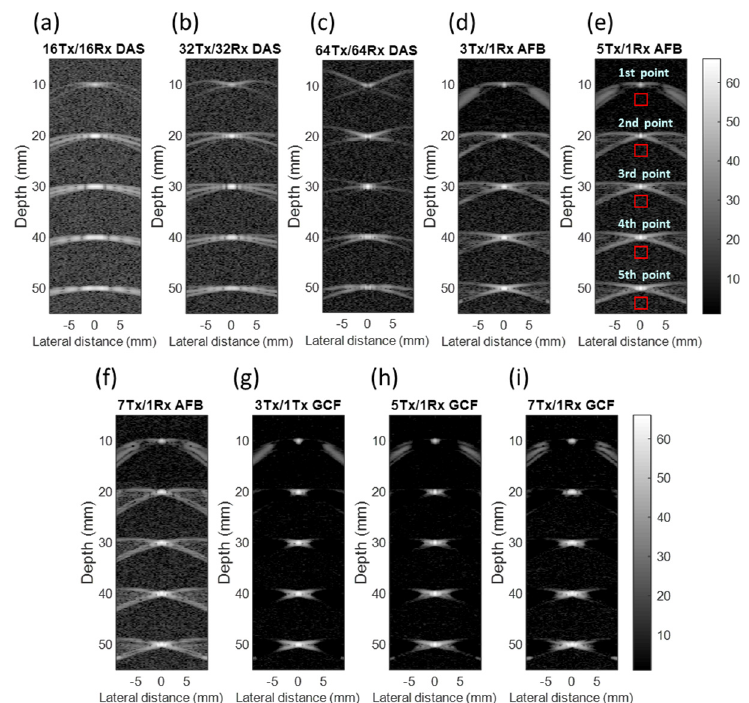
Figure 4. Five-point targets simulation results of nine methods. ( a ) 16 Tx/16 Rx DAS. ( b ) 32 Tx/32 Rx DAS. ( c ) 64 Tx/64 Rx DAS. ( d ) 3 Tx/1 Rx AFB. ( e ) 5 Tx/1 Rx AFB. ( f ) 7 Tx/1 Rx AFB. ( g ) 3 Tx/1 Rx GCF. ( h ) 5 Tx/1 Rx GCF. ( i ) 7 Tx/1 Rx GCF.